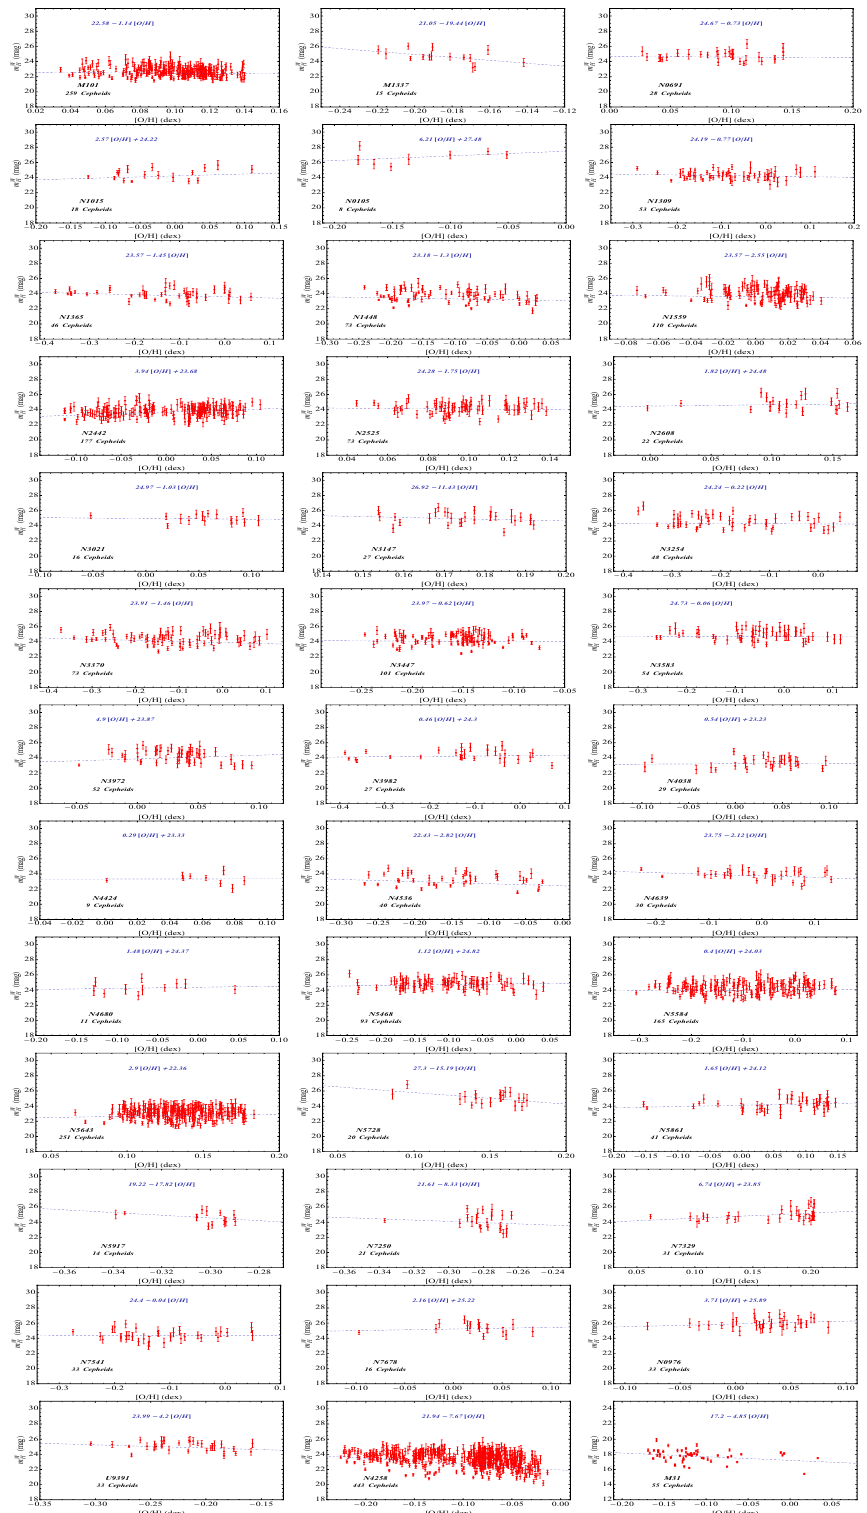
Figure A3. Fitting individual slopes Z W of the m W metallicity relations to Cepheid data for the hosts H where individual Cepheid metallicity data were provided by R21 (only an average metallicity was provided for LMC/SMC and thus these Cepheid hosts are not included in the plot). Thus, the 39 hosts shown correspond to the 37 SnIa+Cepheid hosts, the anchor N4258 and the pure Cepheid host